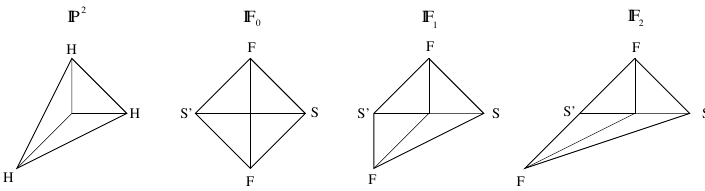
Figure 1 . The reflexive polyhedra ∆ B ∗ associated to the four bases B of the elliptically fibred Calabi-Yau spaces discussed in this